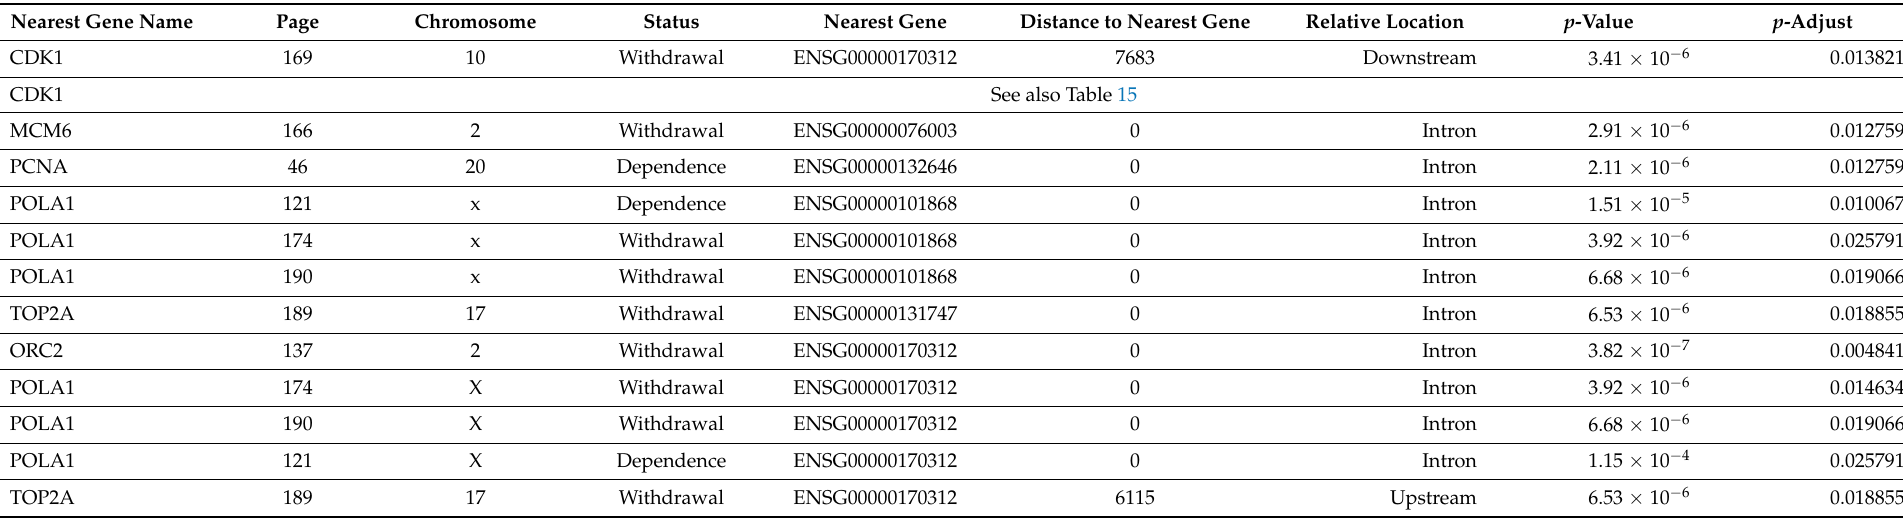
Table 16. Selected EWAS Hits on Cell Cycle Control of Chromosomal Replication Pathways; Data from Schrott